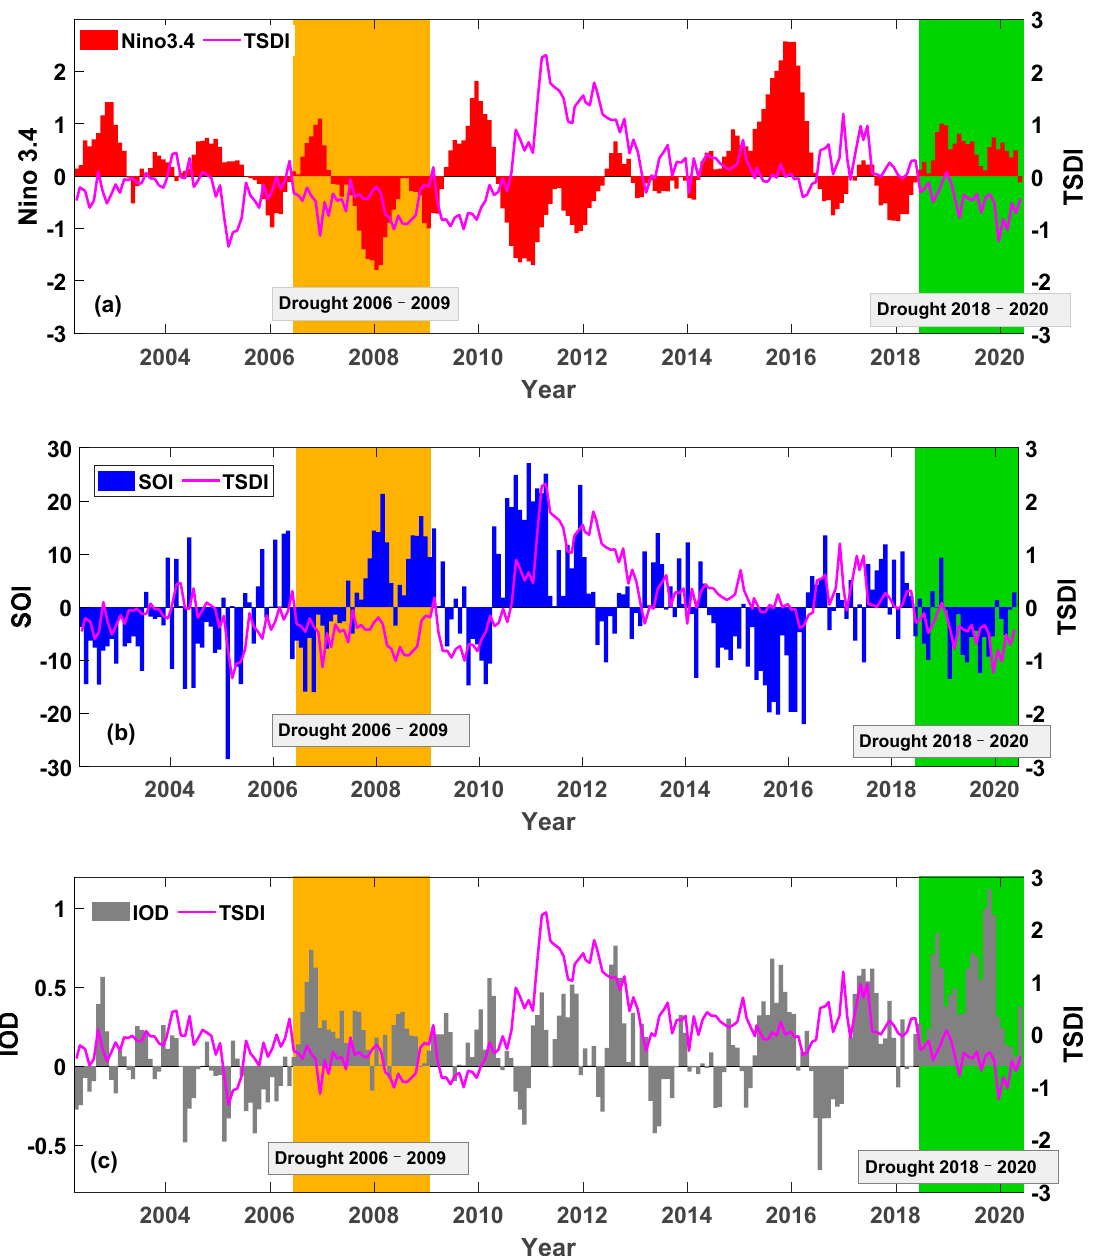
Figure 7. Temporal variability of Indo-Pacific climate indices ( a ) Nino3.4 ( b ) SOI and ( c ) IOD with TSDI from April 2002 to May 2020 (The orange background represents Drought 2006 – 2009 and the green background represents Drought 2018– 2020). Table 5. The maximum mean absolute correlation coefficients and the lagging times between TSDI and climate indices (Nino3.4, SOI and IOD) for the two droughts (unit of lagging time: months). Nino3.4 SOI IOD Drought 2006–2009 0.39/4 0.30/0